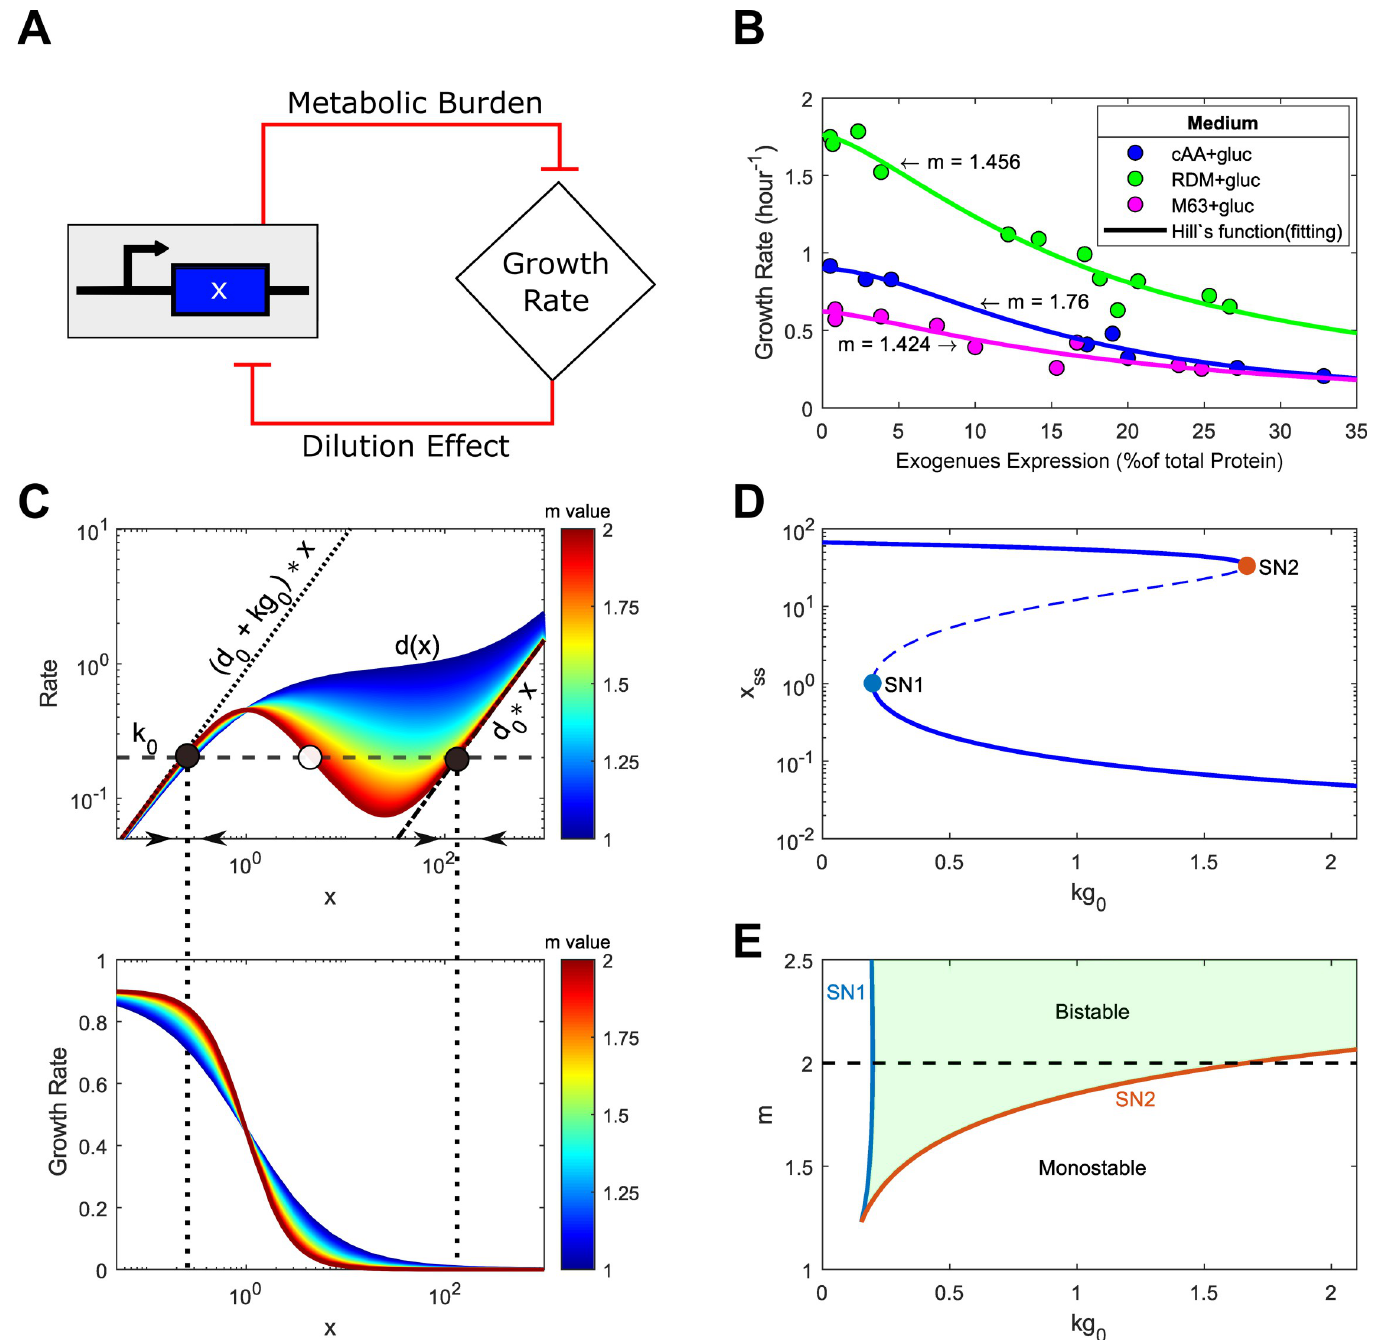
Fig 1. Ultrasensitive cell growth feedback could confer bistability in a simple synthetic gene circuit with a constitutive promoter. (A) Diagram of the mutual inhibition between the host cell growth and synthetic gene expression. (B) Model fitting (solid lines) to experimental data (circle) of the relation between growth rate and exogenous gene expression from different media conditions [14]. (C) Rate balance plot shows the emergence of bistability (top) based on the curves of degradation plus dilution rate versus gene expression ( d ( x )) with various m values (heatmap) and the curve of production versus gene expression f(x) = kg 0 (horizontal black dashed line). Dash-dotted black line shows the degradation rate ( d 0 � x ) curve, and the dotted black line shows the degradation plus max dilution rate ( d 0 � x+kg 0 � x ). Solid and open circles represent stable and unstable steady states, respectively. The black arrows on the x-axis denote the directional field. Vertical dotted lines between the top and bottom panels represent the x values at the stable states. The corresponding growth rate curves versus gene expression are shown at the bottom. (D) Bifurcation diagram of the gene expression x with respect to kg 0 . Solid and dashed lines represent stable and unstable steady states with m = 2, respectively. (E) Two-parameter bifurcation diagram with respect to m and kg 0 . SN1 (blue line) and SN2 (orange line) are the saddle-node bifurcation points shown in (D). The enclosed green region between the saddle nodes represents the bistability. The black dashed line corresponds to the case shown in (D) with m = 2.